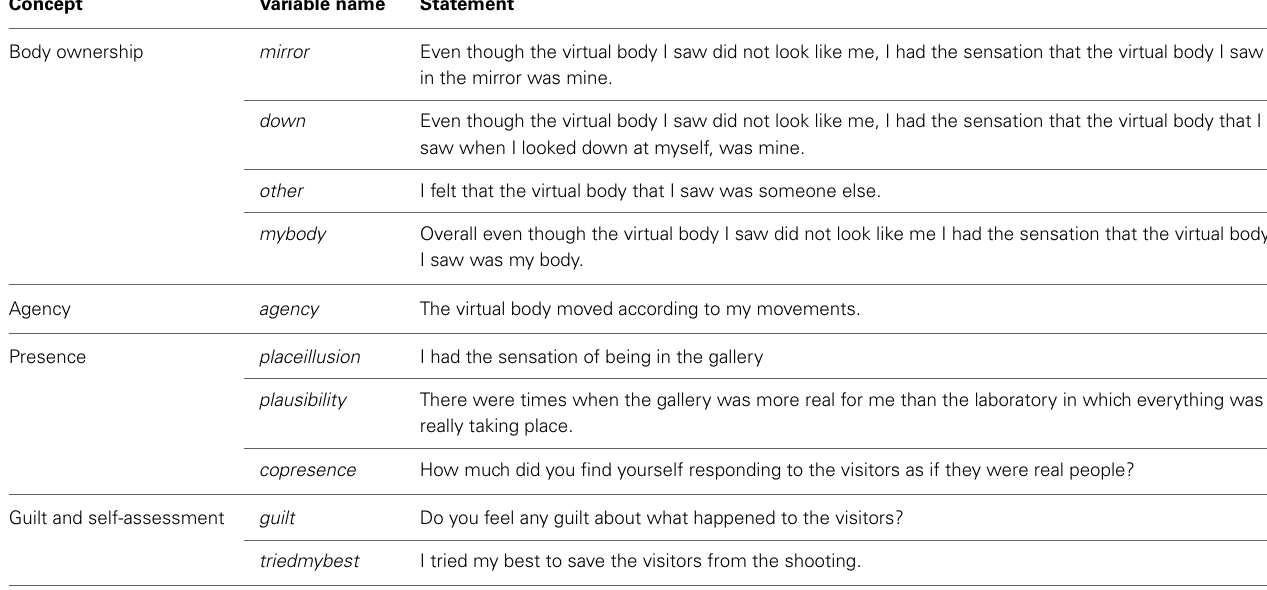
Table 1 | Questions for body ownership, agency, presence, and guilt.